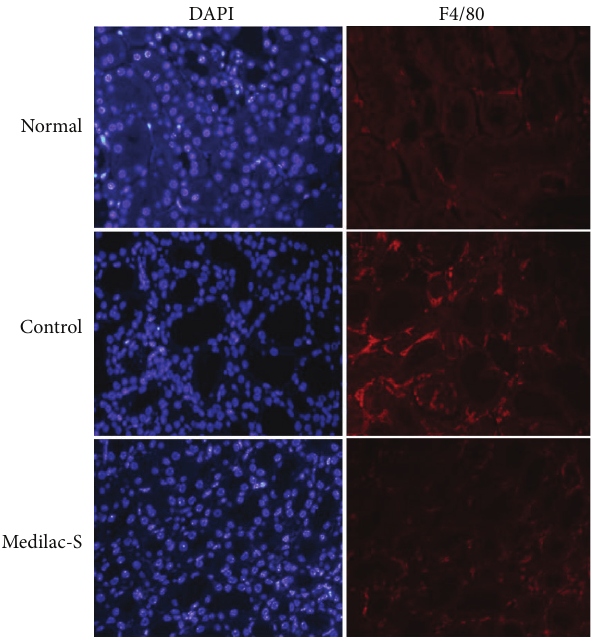
Figure 3: Infiltration of macrophages into the lower segments of colons from normal, control, and Medilac-S rats. Representative images of lower segments of colons tissue stained with DAPI (blue) and F4/80 (red). The result has shown that rare macrophages labeled withF4/80infiltratedintheintestinaltissueinthenormalgroup.But after establishment of murine model of colitis, a few macrophages infiltrated into the local intestinal. And the treatment with Medilac- S reduced the infiltrated macrophages